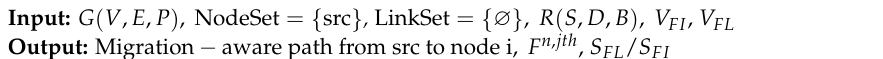
Table 2. Detailed procedures of BMA-RSA algorithm. Algorithm 1. Brown-field Migration aware routing and spectrum assignment ( BMA-RSA ) algorithm